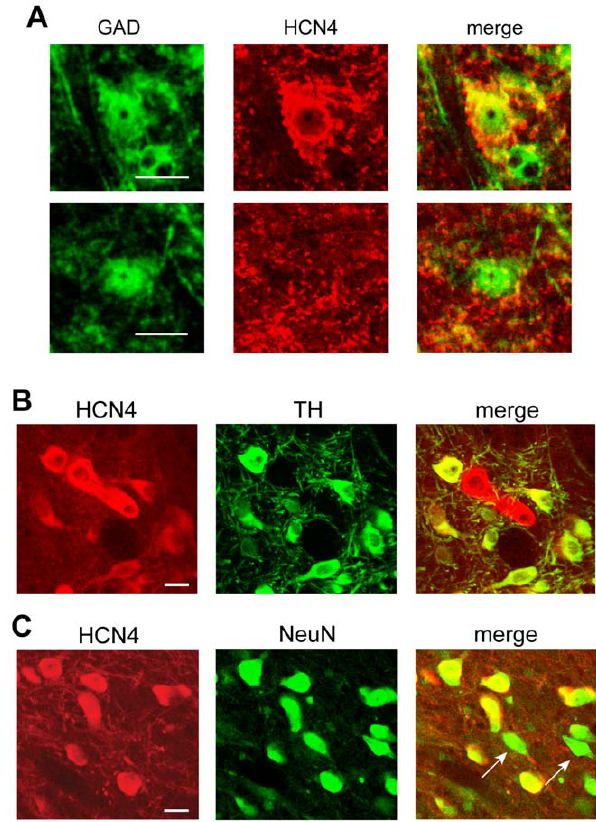
Figure 6. VTA neurons express HCN protein. (A) Immunocyto- chemical colabeling in VTA tissue for GAD and HCN4, one of the channels expressed in the VTA that produces the I h , yields examples of GAD( + ) neurons that are HCN4( + ) (top) or HCN4( 2 ) (bottom), consistent with the physiology. Scale bars: 20 m m. (B) Immunocytochemical colabeling for HCN4 and TH in VTA slices shows that HCN4 is expressed in some TH( 2 ) neurons. Scale bar: 20 m m. (C) The HCN4 antibody was not non-specifically labeling all neurons as HCN4 colabeling with the neural marker NeuN shows that some VTA neurons were cytochemically HCN4( 2 ). Scale bar: 20 m